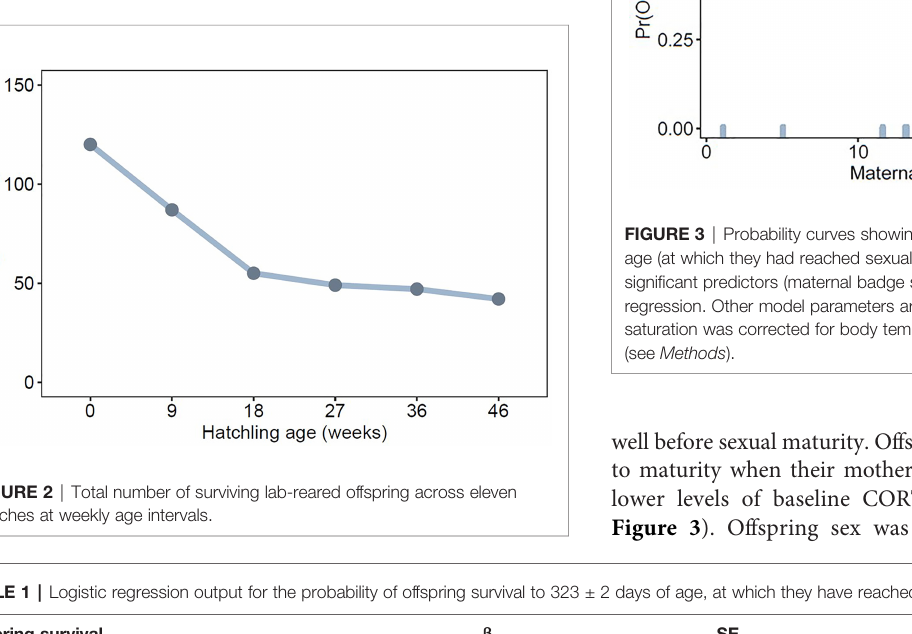
Figure 3 ). Offspring sex was not a signi fi cant predictor of